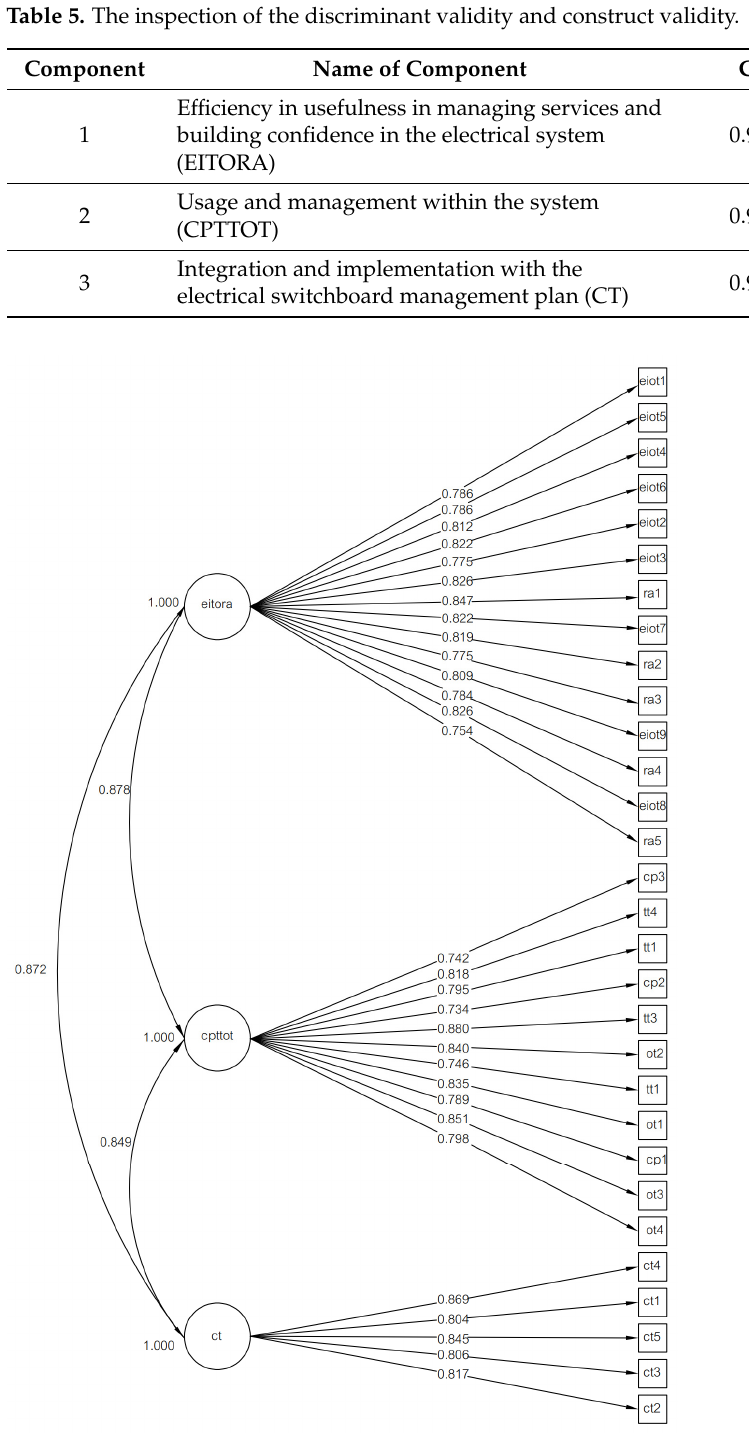
Figure 6. Analysis model for the composition of each variable.